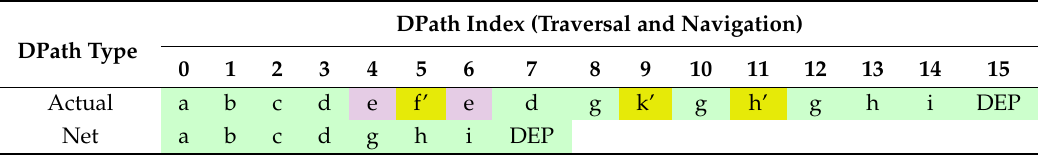
Figure 4. Normalized DPath information vs. composition index, l , by skill index. Table 1. Comparison of Figure 2